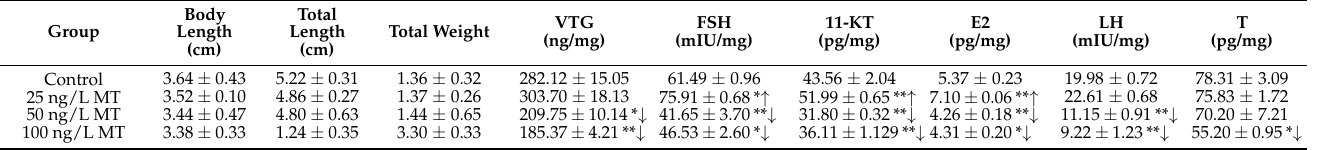
Table 1. Biological indicators and the contents of hormones in the treatment and control